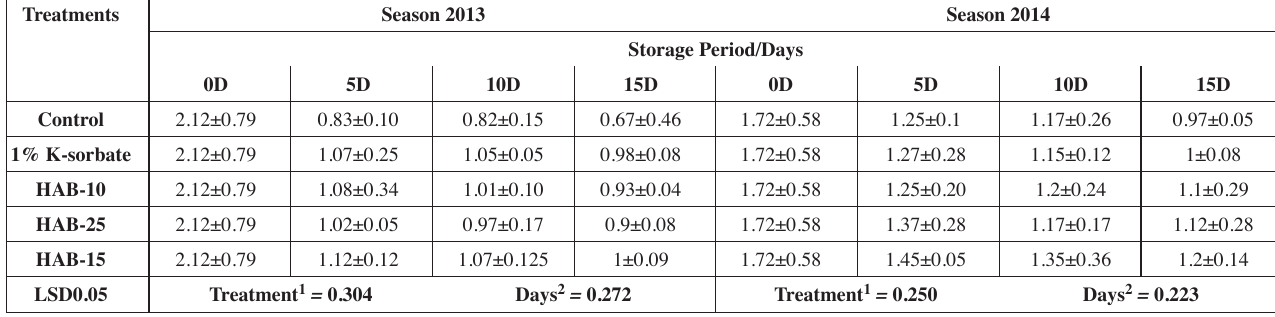
Tab. 4: Effect of fluorescent Pseudomonas species on firmness (N) of tomato stored at 23±4 ºC with relative humidity in the range of 25% - 70%.